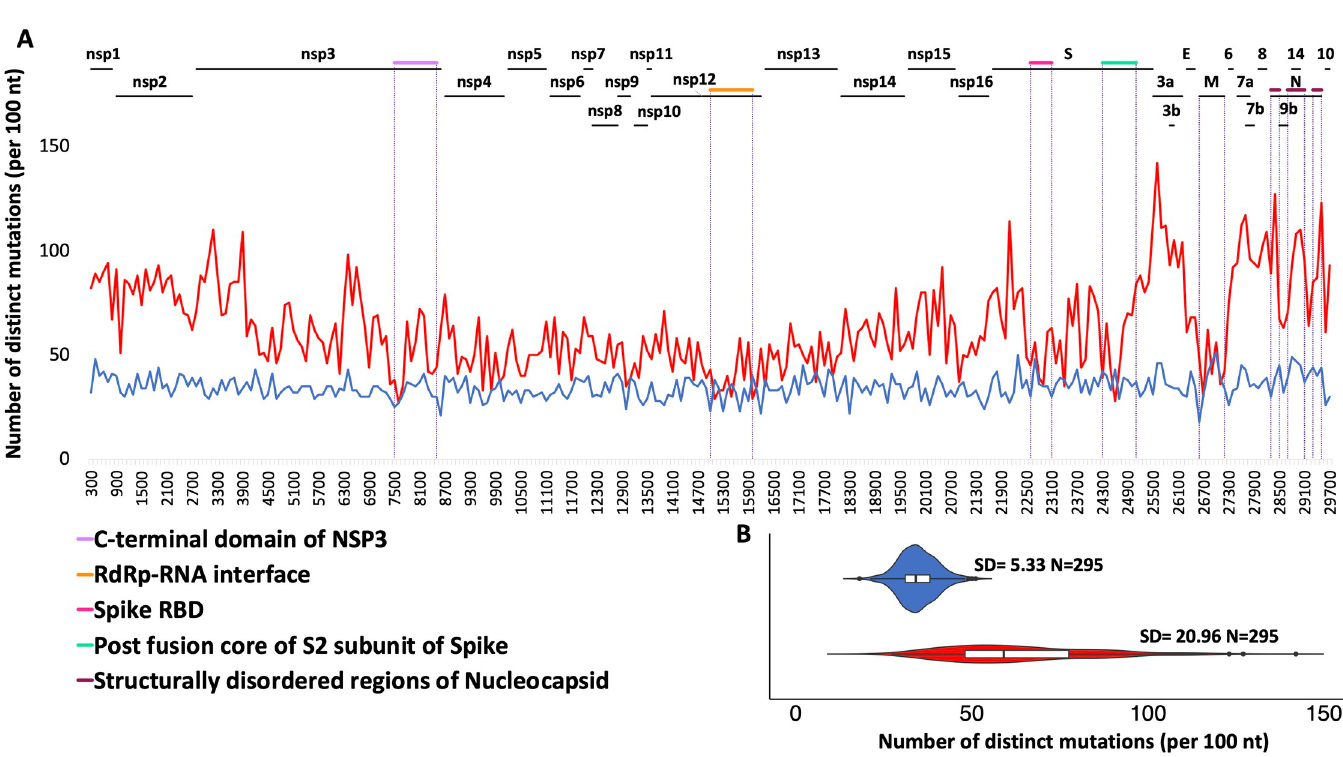
Fig 1. Distribution of SARS-CoV-2 mutations based on multiple sequence alignment of 192,030 high-coverage genomes. A). Rate of missense (red) and synonymous (blue) mutations in windows of 100 nt. B) Violin plots highlight the differences in the distributions of missense and synonymous mutations in windows of 100 nt. SD; Standard